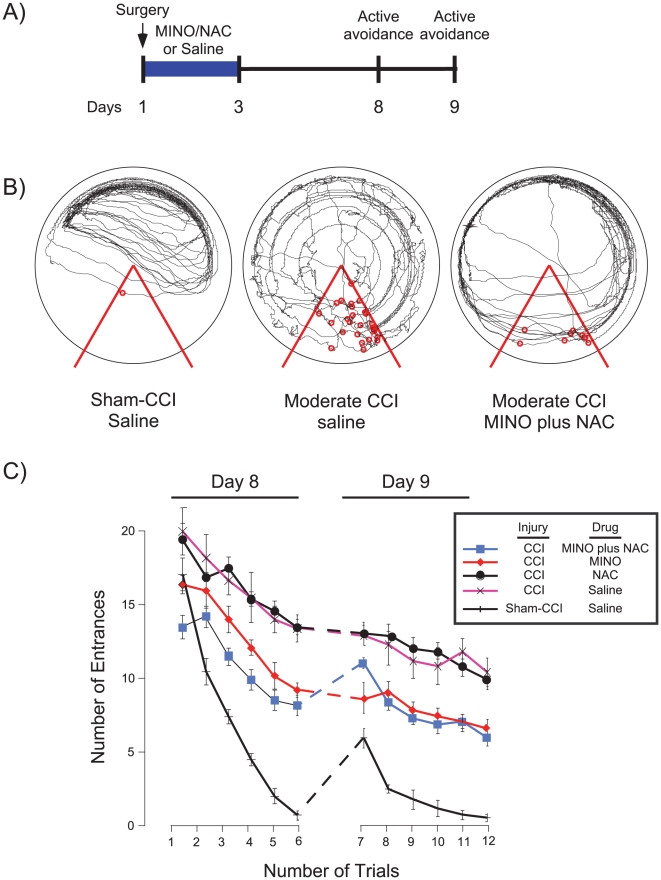
MINO plus NAC synergistically improved active place avoidance after massed training.Panel A, Rats received either CCI or sham-CCI. One hour, one or days later the sham-injured the CCI-injured rats were divided into 4 groups; one group received saline treatment. The remaining CCI-injured rats received either MINO or NAC alone, or the combination of MINO plus NAC. Saline or drug treatments were administered 1 hour, 1 day and 2 days after injury. Rats received active place avoidance training 8 and 9 days after injury. On the 8th and 9th day following CCI, the number of shock zone entrances was measured. Panel B, Representative tracks of rats in the sham-CCI-saline, CCI-saline or CCI-MINO plus NAC groups on the 6th trial on the first day of active avoidance training. Red lines indicate the boundaries of the shock zone and the red circles indicate the location were a rat received a shock. Panel C, Summary of the number of shock zone entrances over the two days of active place avoidance.